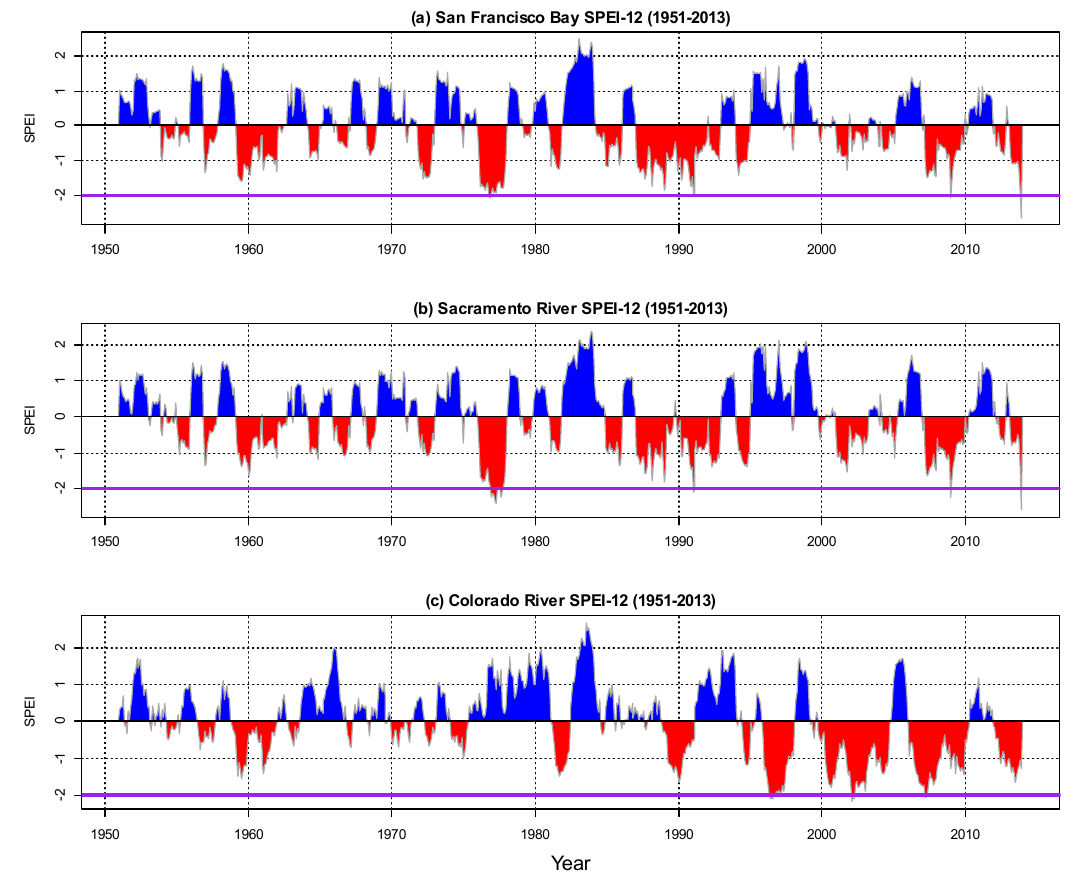
Figure 3. SPEI-12 of: ( a ) San Francisco Bay region; ( b ) Sacramento River region; and ( c ) Colorado River region during the historical period (1951–2013). Blue color indicates wet conditions; red color designates drought conditions. The purple line is the threshold below which extreme drought conditions exist.